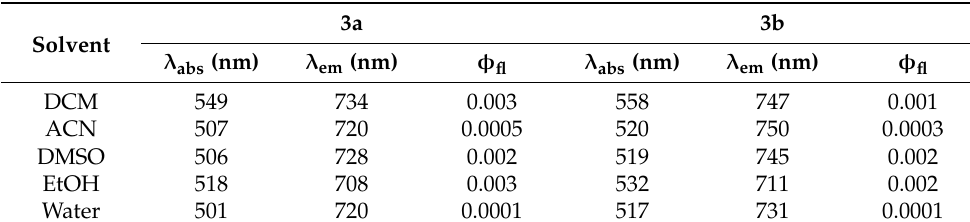
Table 1. Spectroscopic properties of 3a and 3b .